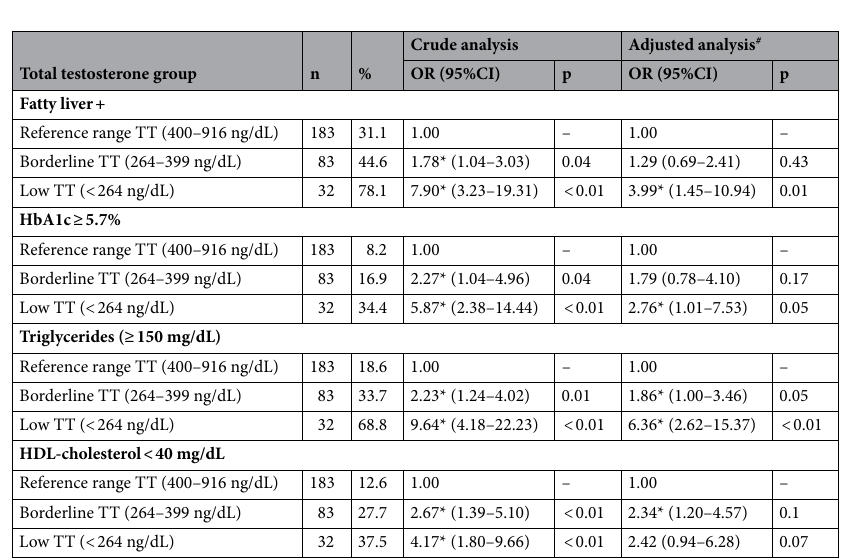
Table 4. Odds ratio of having various metabolic abnormalities in male career firefighters with borderline or low total testosterone (TT) levels compared to those with TT in the reference range. TT: total testosterone; p: Pearson’s Chi-square p-value. # Adjusted for body mass index, age, and HbA1c; *Significantly different when compared to reference